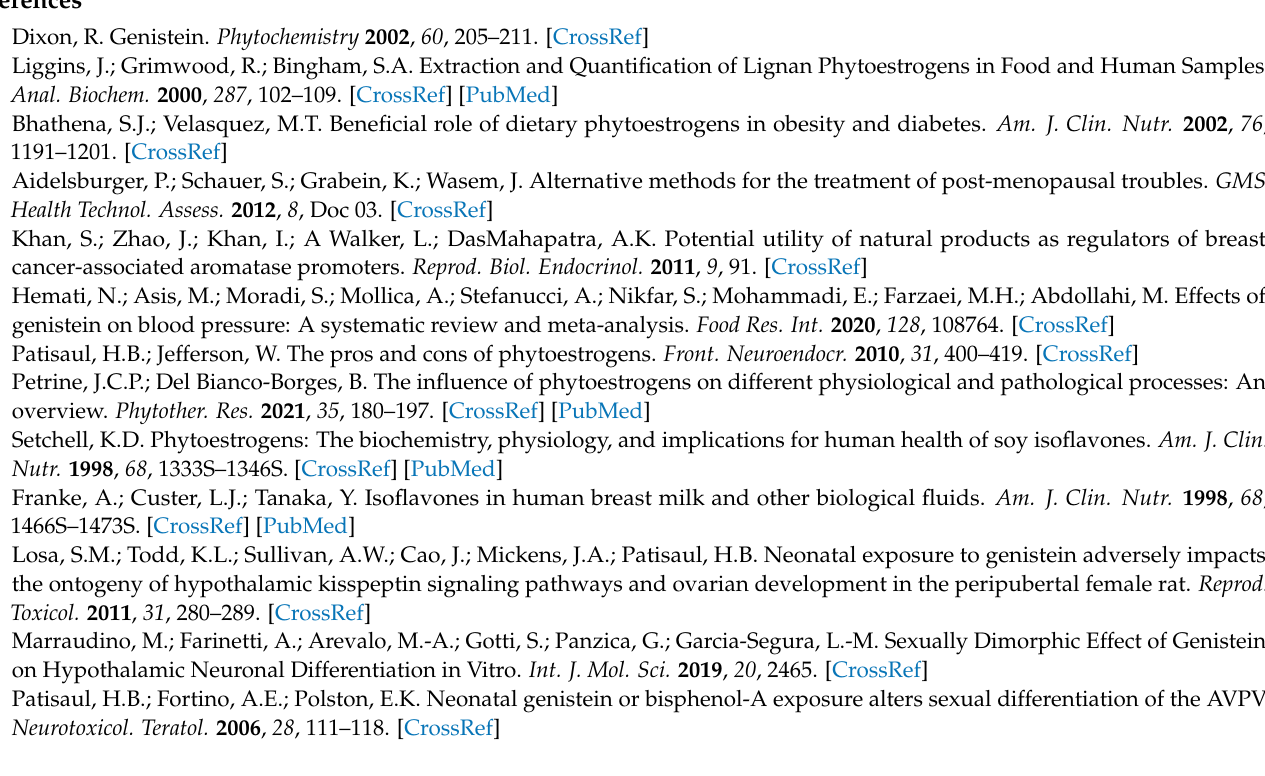
Table S2: Fecal testosterone concentration, Table S3: Kisspeptin system: quantitative data, Table S4: Body weight gain, Table S5: Daily food eaten, Table S6: Daily feed efficiency, Table S7: POMC system: quantitative data, Table S8: POMC and orexin system: developmental data, Table S9: Orexin system: quantitative